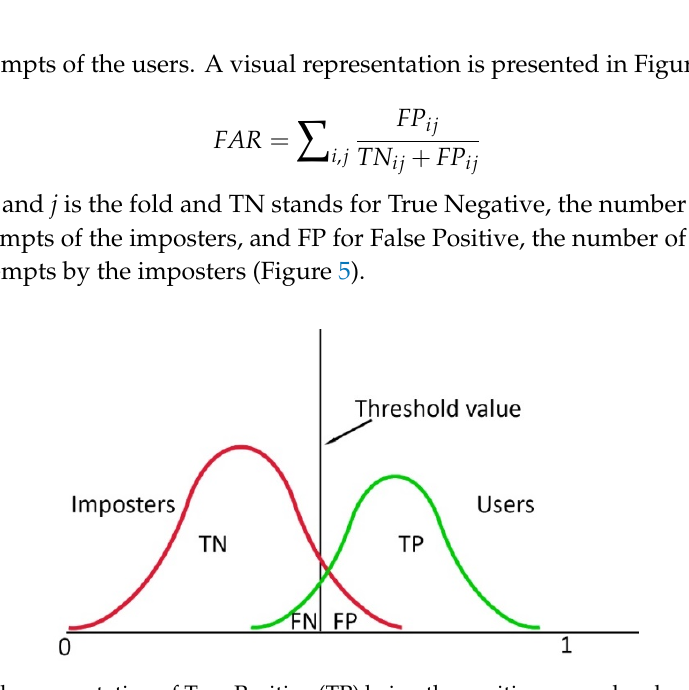
Table 1. Accuracies, FRR and FAR for 8 ‐ channel models, 16 ‐ channel models, 64 ‐ channel models using the optimal threshold. The standard deviation (std) can be found between brackets and the area under curve (AUC) the area under the ROC curve.